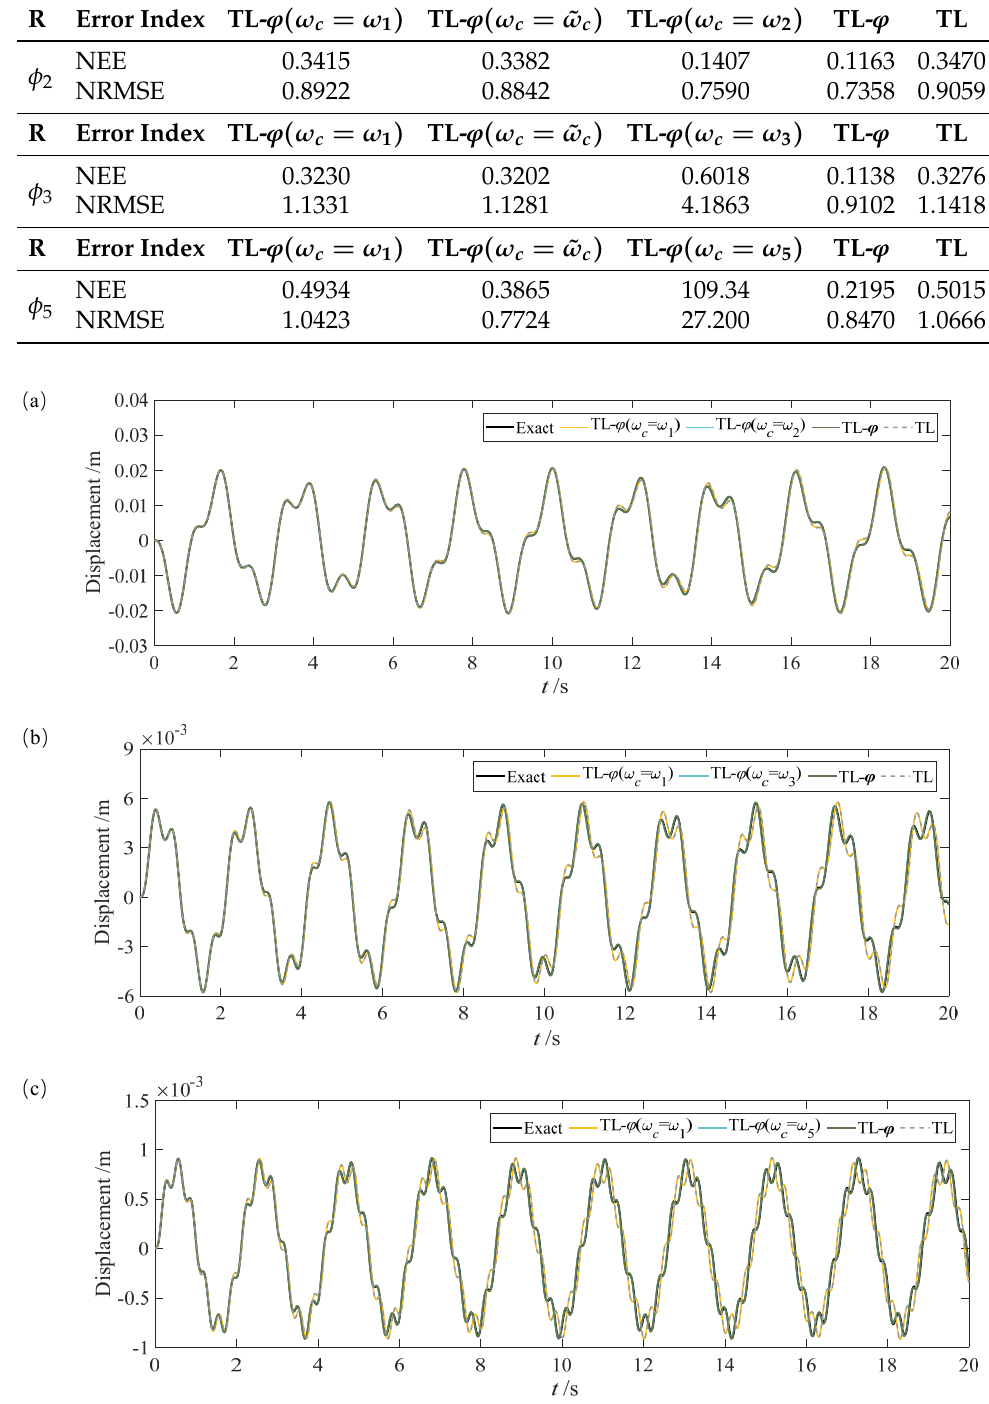
Figure 9. Displacement responses of the 5-story building (G1). ( a ) R = φ 2 . ( b ) R = φ 3 . ( c ) R = φ 5